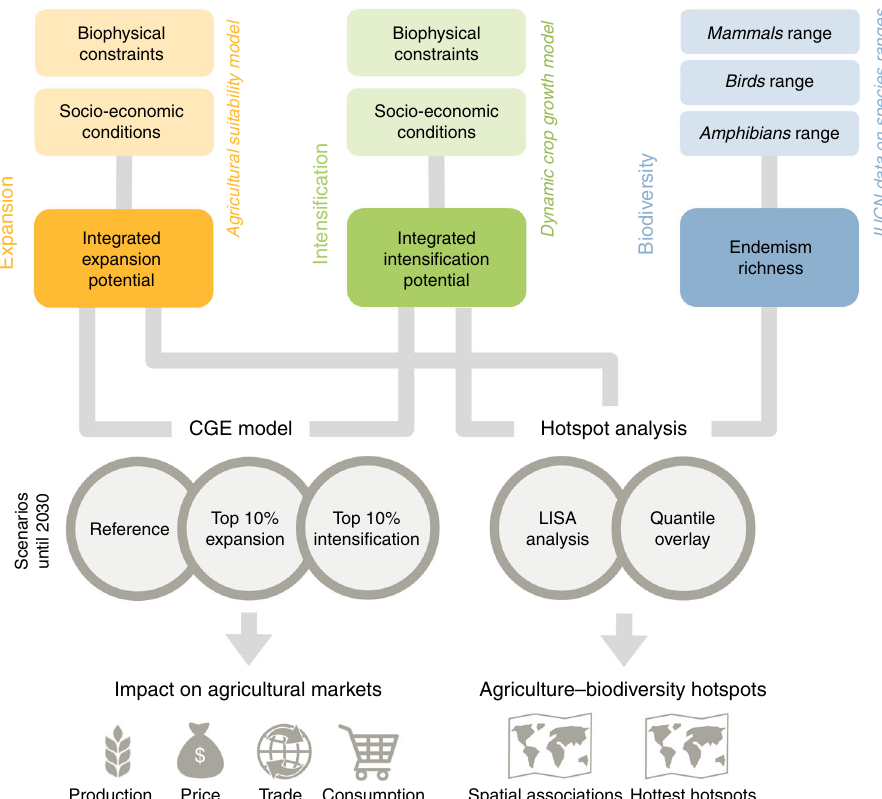
Fig. 1 Overview of the study design. The study is based on three sources of data on global cropland expansion, intensi fi cation and biodiversity. Both maps of cropland expansion potential and intensi fi cation potential are simulated for 17 major agricultural crops at 30 arc sec resolution and integrate information on biophysical constraints (e.g. topography, soil quality, climate change) and socio – economic conditions (e.g. population growth, consumption patterns). The integrated cropland expansion potential is developed by a model of near-future agricultural suitability, while the integrated cropland intensi fi cation potential is developed by a dynamic crop growth model. A computable general equilibrium (CGE) model of the world economy, applied to two scenarios of cropland expansion and intensi fi cation until 2030, quanti fi es the impact on agricultural markets in terms of crop production, price, trade and consumption. We use a reference scenario up to 2030 for reference that carries forward current trends in population growth, gross domestic product and trade policies. Endemism richness integrates IUCN range maps of 19,978 species of mammals, birds and amphibians into a global biodiversity metric aggregated at 55-km resolution of an equal-area grid. This metric combines species richness with a measure of endemism (i.e. the range sizes of species within an assemblage) and thus indicates the relative importance of a site for conservation. Hotspot analysis, using Local Indicator of Spatial Association (LISA) and quantile overlay, identi fi es hotspots where global biodiversity is most affected by near-future cropland expansion and intensi fi